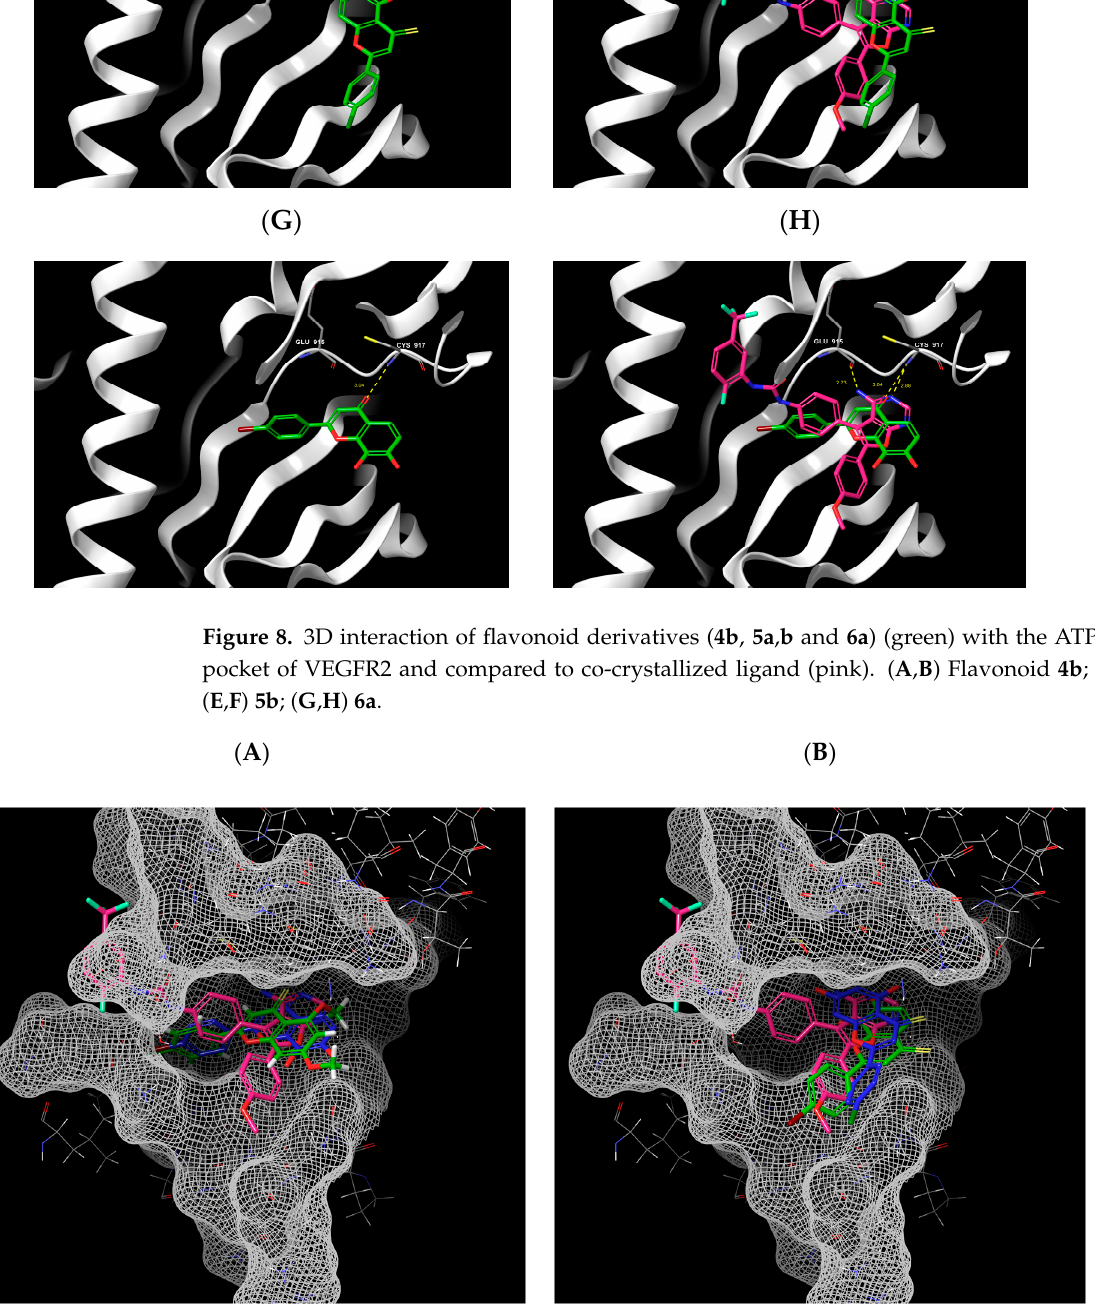
Figure 9. Mesh representation of flavonoid derivatives ( 4b , 5a , b and 6a ) in the ATP-binding pocket of VEGFR2 compared to co-crystallized ligand (pink). ( A ) Less active horizontal orientation of flavonoids 4b (green) and 6a (blue); ( B ) more active vertical orientation of flavonoids 5a (green) and 5b (blue).